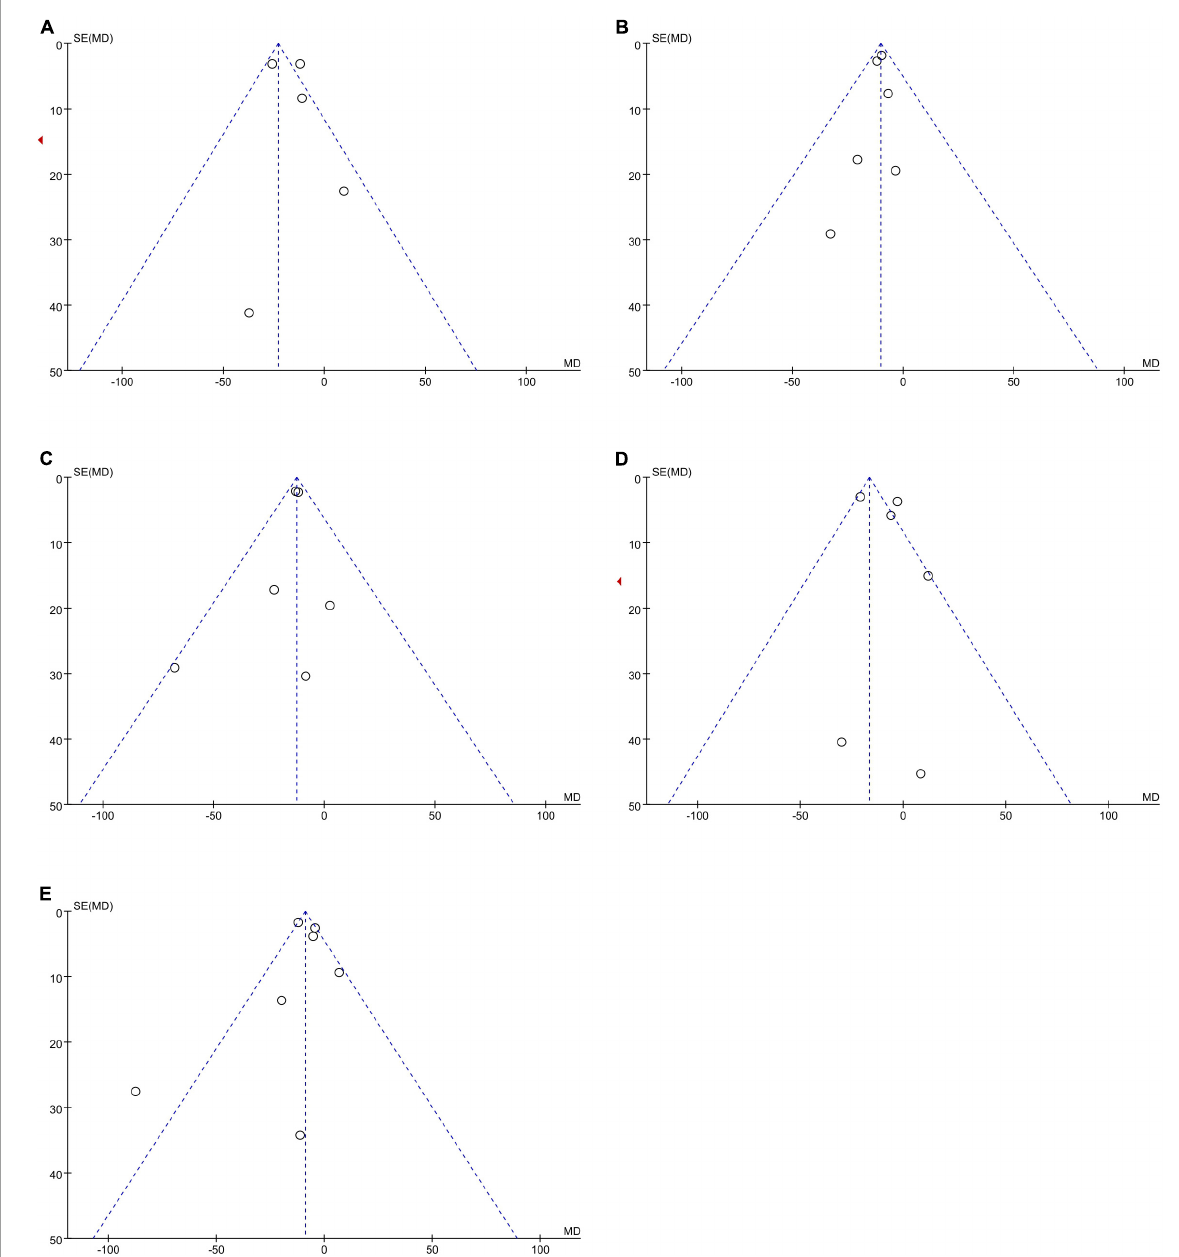
2,777 patients in 10 articles were included. We found that the bleeding risk of patients taking dabigatran with GG and GT genotypes was significantly lower than that of patients with TT genotype; the bleeding risk of patients with GG genotype was remarkably lower than that of patients with GT + TT genotypes. Moreover, the bleeding risk is lower in patients carrying the G allele compare to T allele carriers. Additionally,